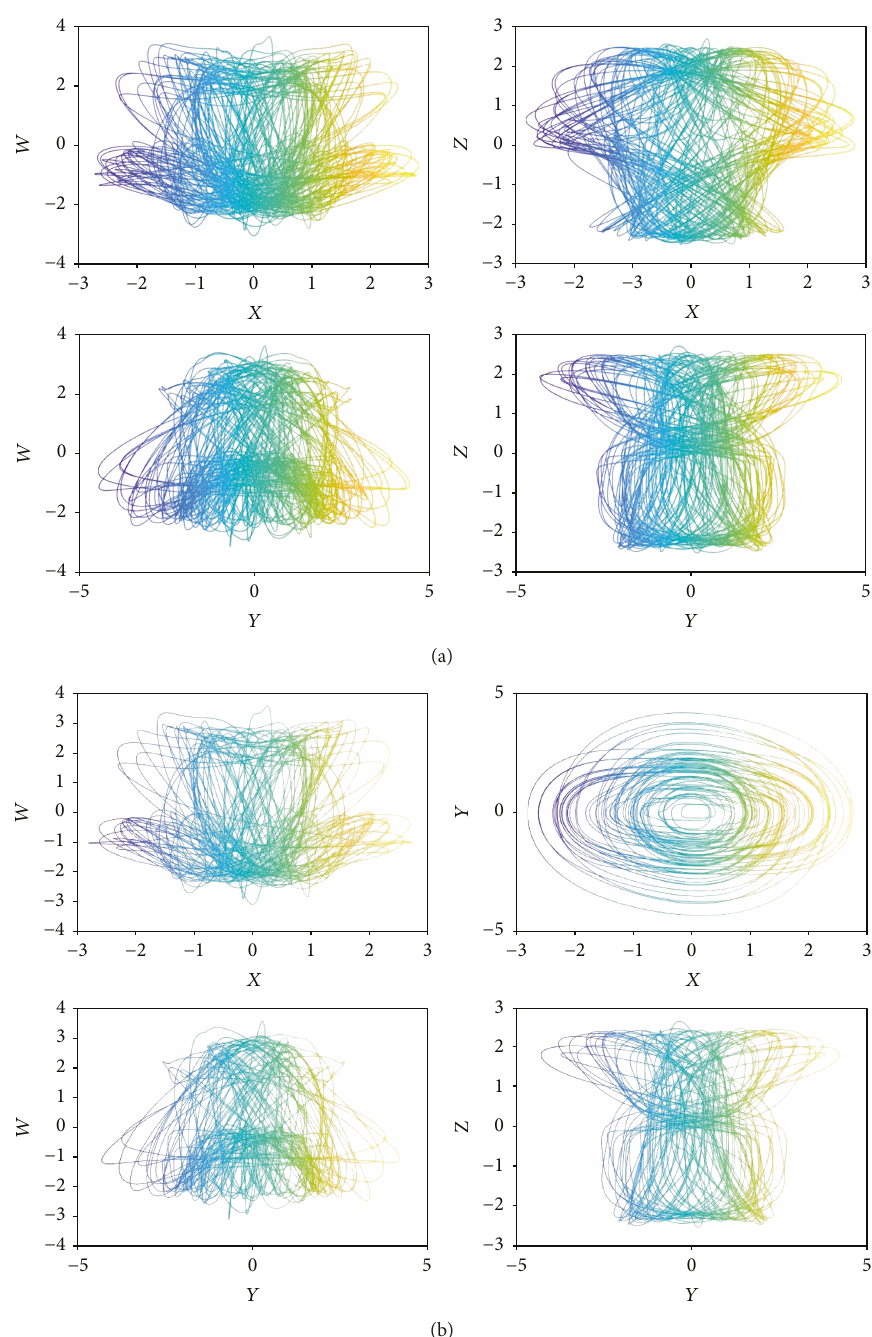
Figure 2: 2D phase plots of the FOPCC system for (a) d = 3 and (b) d = 9 5 with the initial conditions 1, 1, 1, 1, 1